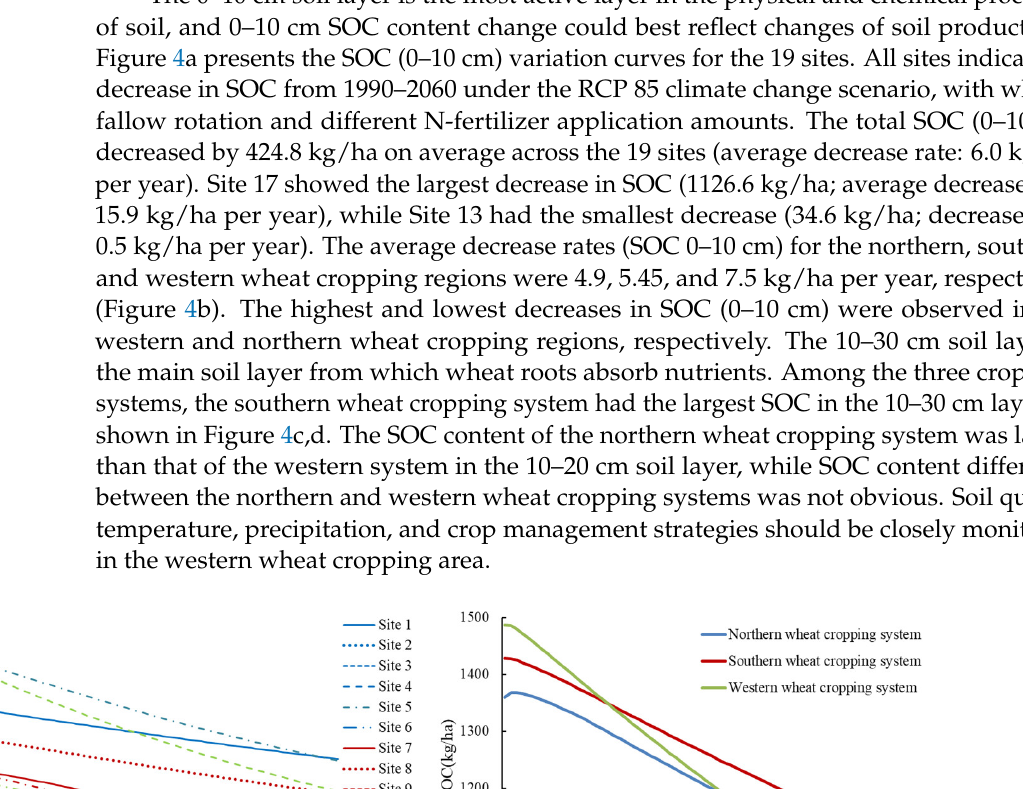
Figure 4. SOC changes during 1990–2060. ( a ) The 0–10 cm SOC change for the 19 observation sites. ( b ), ( c ), and ( d ) show 0–10, 10–20, 20–30 cm average SOC for the three wheat cropping regions, respectively. In ( d ), the lines representing the ‘northern wheat cropping system’ and ‘western wheat cropping system’ overlap. 3.3. Scenarios Simulation Scenario simulation provided average results for 19 sites, shown in Table 4. The SOC had decreased for all six scenarios by the end of 2060. The smallest decrease for SOC was in Scenario Ⅵ (165.8 kg/ha) and the largest was in Scenario Ⅰ (1351.3 kg/ha). With the in- crease of N-fertilizer application rate, SOC decreased for both wheat–fallow rotation and legume–wheat rotation. The SOC (0–30 cm) at the start of 1990 for wheat–fallow rotation was 3712.9 kg/ha on average, and 2470.3 kg/ha by the end of 2060. The SOC (0–30 cm) at the start of 1990 for legume–wheat rotation was 3912.6 kg/ha on average and 3530.97 kg/ha by the end of 2060 (Table 4), which indicated that legume–wheat rotation could effectively reduce SOC loss. Mineral N is a key factor for SOC change, and has a close relationship with N-fertilizer rate, which inhibits C mineralization and promotes SOC increase. With the increase of N-fertilizer rate (0/12/50 kg N/ha/year), mineral N values for wheat–fallow rotation were 2.5/3.0/3.1 kg N/ha/year by the end of 2060, and for legume–wheat rotation were 7.9/6.7/5.9 kg N/ha. There was a positive relationship between N-fertilizer rate and mineral N for wheat–fallow rotation, and an inverse relationship for legume–wheat rota- tion. Since our study focused primarily on the impact of cropland management strategies on SOC, we added two parameters to the uncertainty analysis, i.e., mineral N (mainly affected by N-fertilizer) and rotation, based on Luo’s conclusion. Therefore, our uncer- tainty analysis input parameters included C input, soil properties, initial SOC, climate factors (temperature, precipitation), N-fertilizer, and rotation. Clay is one of the most sen- sitive parameters of soil in the DNDC model, because clay not only determines soil texture but also affects other soil parameters (such as coefficient of withering, field capacity,